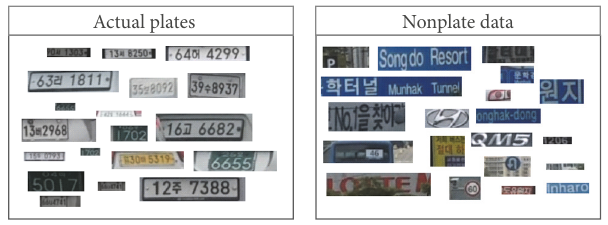
Figure 8: Example images for SVM training.